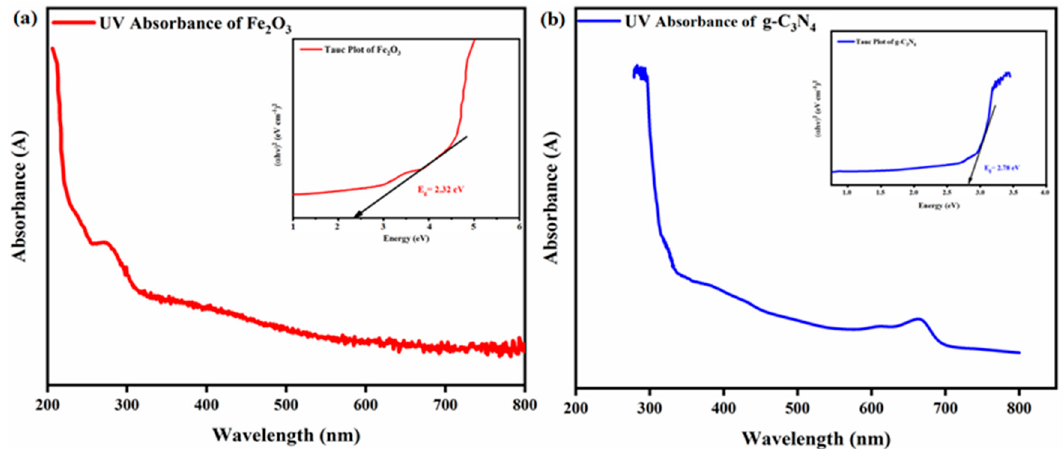
Figure 7. Efficiency comparison of ( a ) RhB dye and ( b ) MB dye by using Ce- and Yb-based nanocomposites.